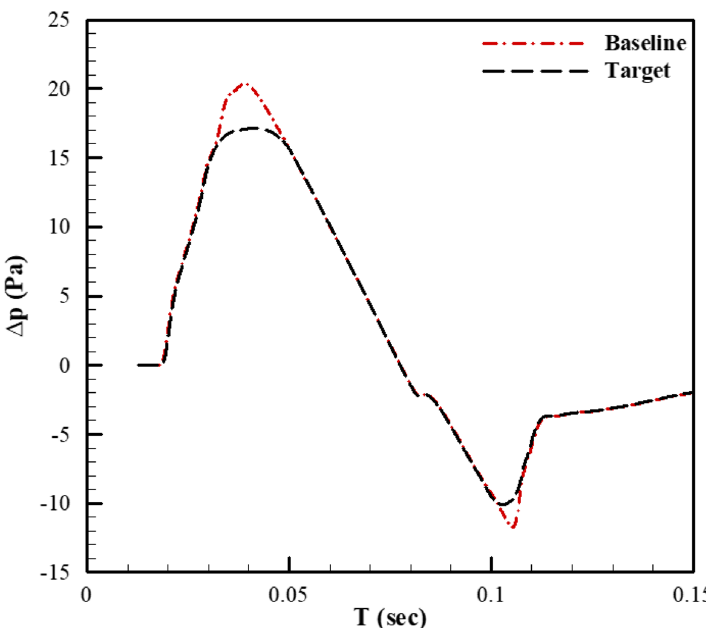
Fig. 10 Target far-field